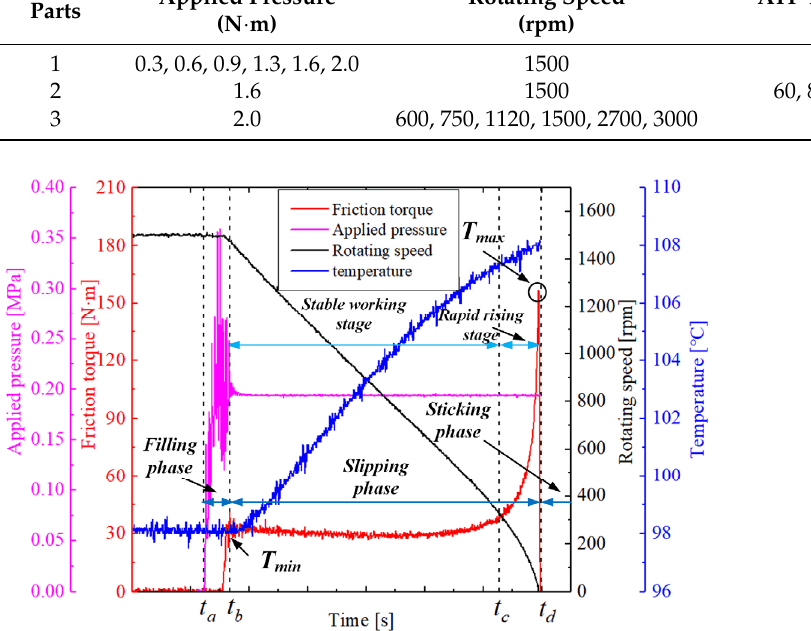
Figure 3. Representative measurement signals.